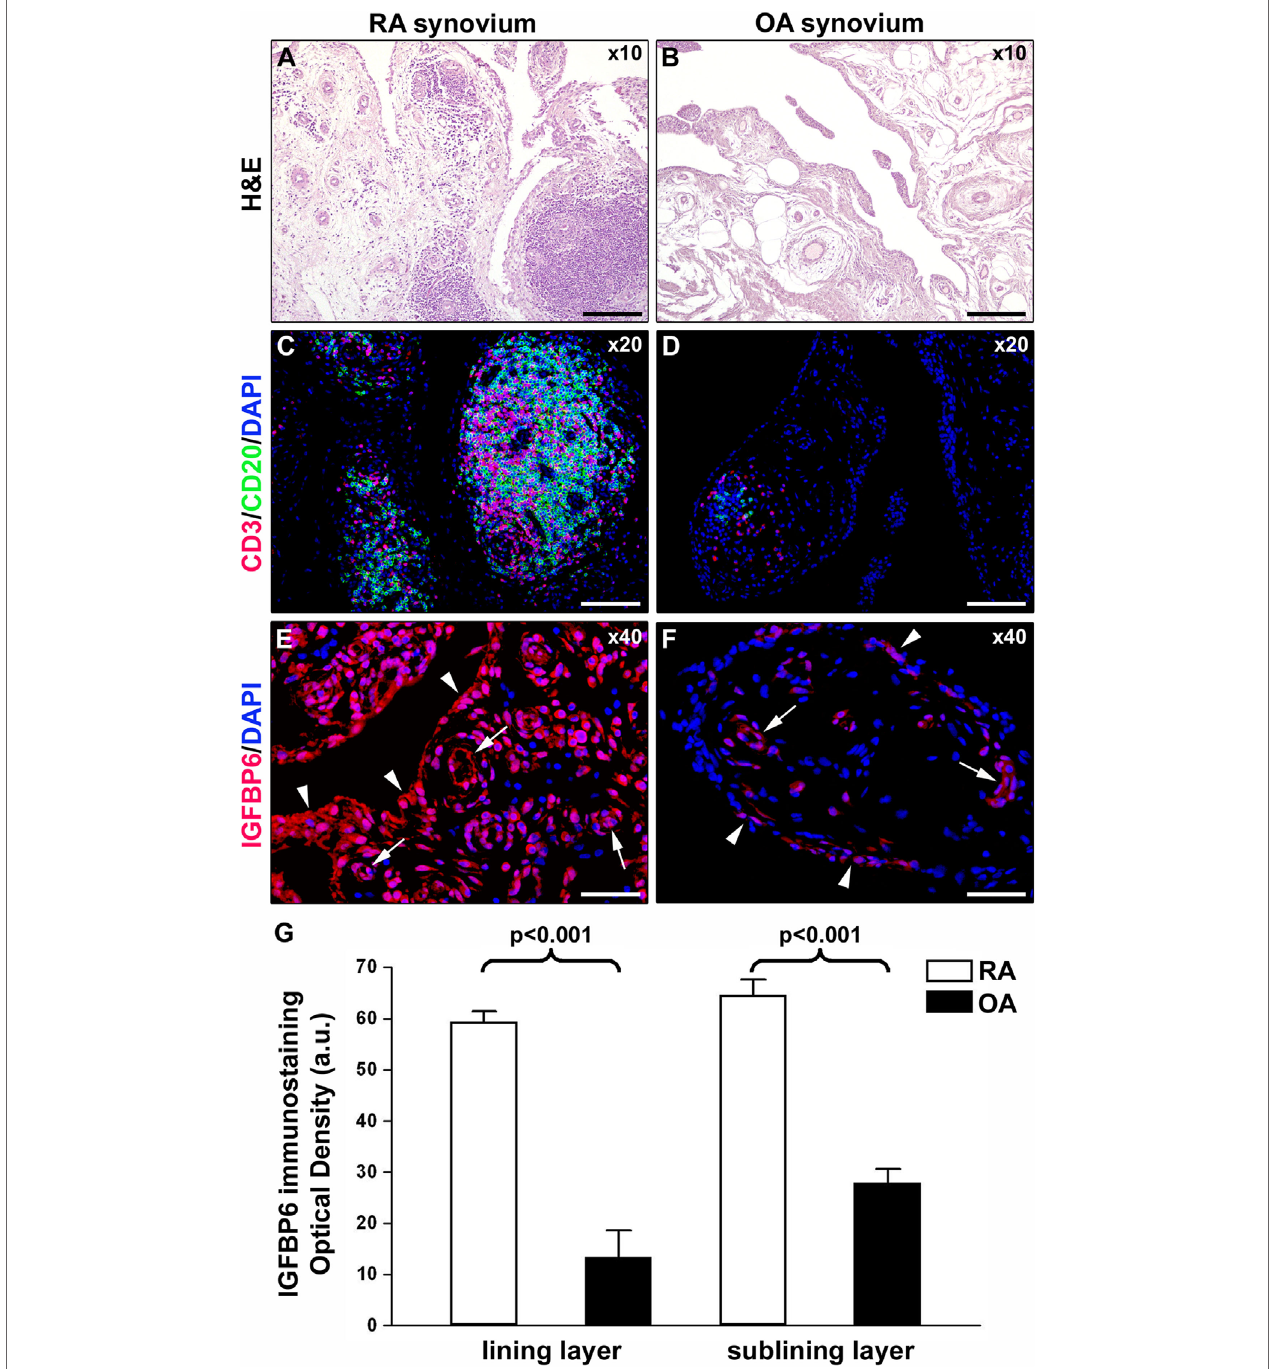
FigUre 3 | insulin-like growth factor binding protein 6 (igFBP6) expression in synovial tissue from patients with rheumatoid arthritis (ra) and osteoarthritis (Oa) . Representative microphotographs of synovial membrane sections from patients with RA (a,c,e) and patients with OA (B,D,F) are shown. (a,B) Hematoxylin and eosin (H&E) staining. (c,D) Double immunofluorescence staining for CD3 (red) and CD20 (green) with 4 ′ ,6-diamidino-2-phenylindole (DAPI, blue) counterstain for nuclei. RA synovial membrane displays either diffuse immune cell infiltrates or ectopic lymphoid structures composed of T and B cells (a,c) . Few scattered T and B cells are present in OA synovium (B,D) . (e,F) Immunofluorescence staining for IGFBP6 (red) with DAPI (blue) counterstain. IGFBP6 is strongly expressed in different cells of the lining and sublining layers of RA synovium (e) . Faint expression of IGFBP6 is detected in OA synovium (F) . Arrowheads indicate synovial lining layer. Arrows indicate microvessels in synovial sublining layer. Original magnification: × 10 (a,B) , × 20 (c,D) , and × 40 (e,F) . Scale bar: 200 µm (a,B) , 100 µm (c,D) , and 50 µm (e,F) . (g) Densitometric analysis of IGFBP6 immunofluorescent staining intensity in lining and sublining layers of RA ( n = 7) and OA ( n = 6) synovium expressed as optical density in arbitrary units (a.u.). Data are mean ± SD. Student’s t -test was used for statistical